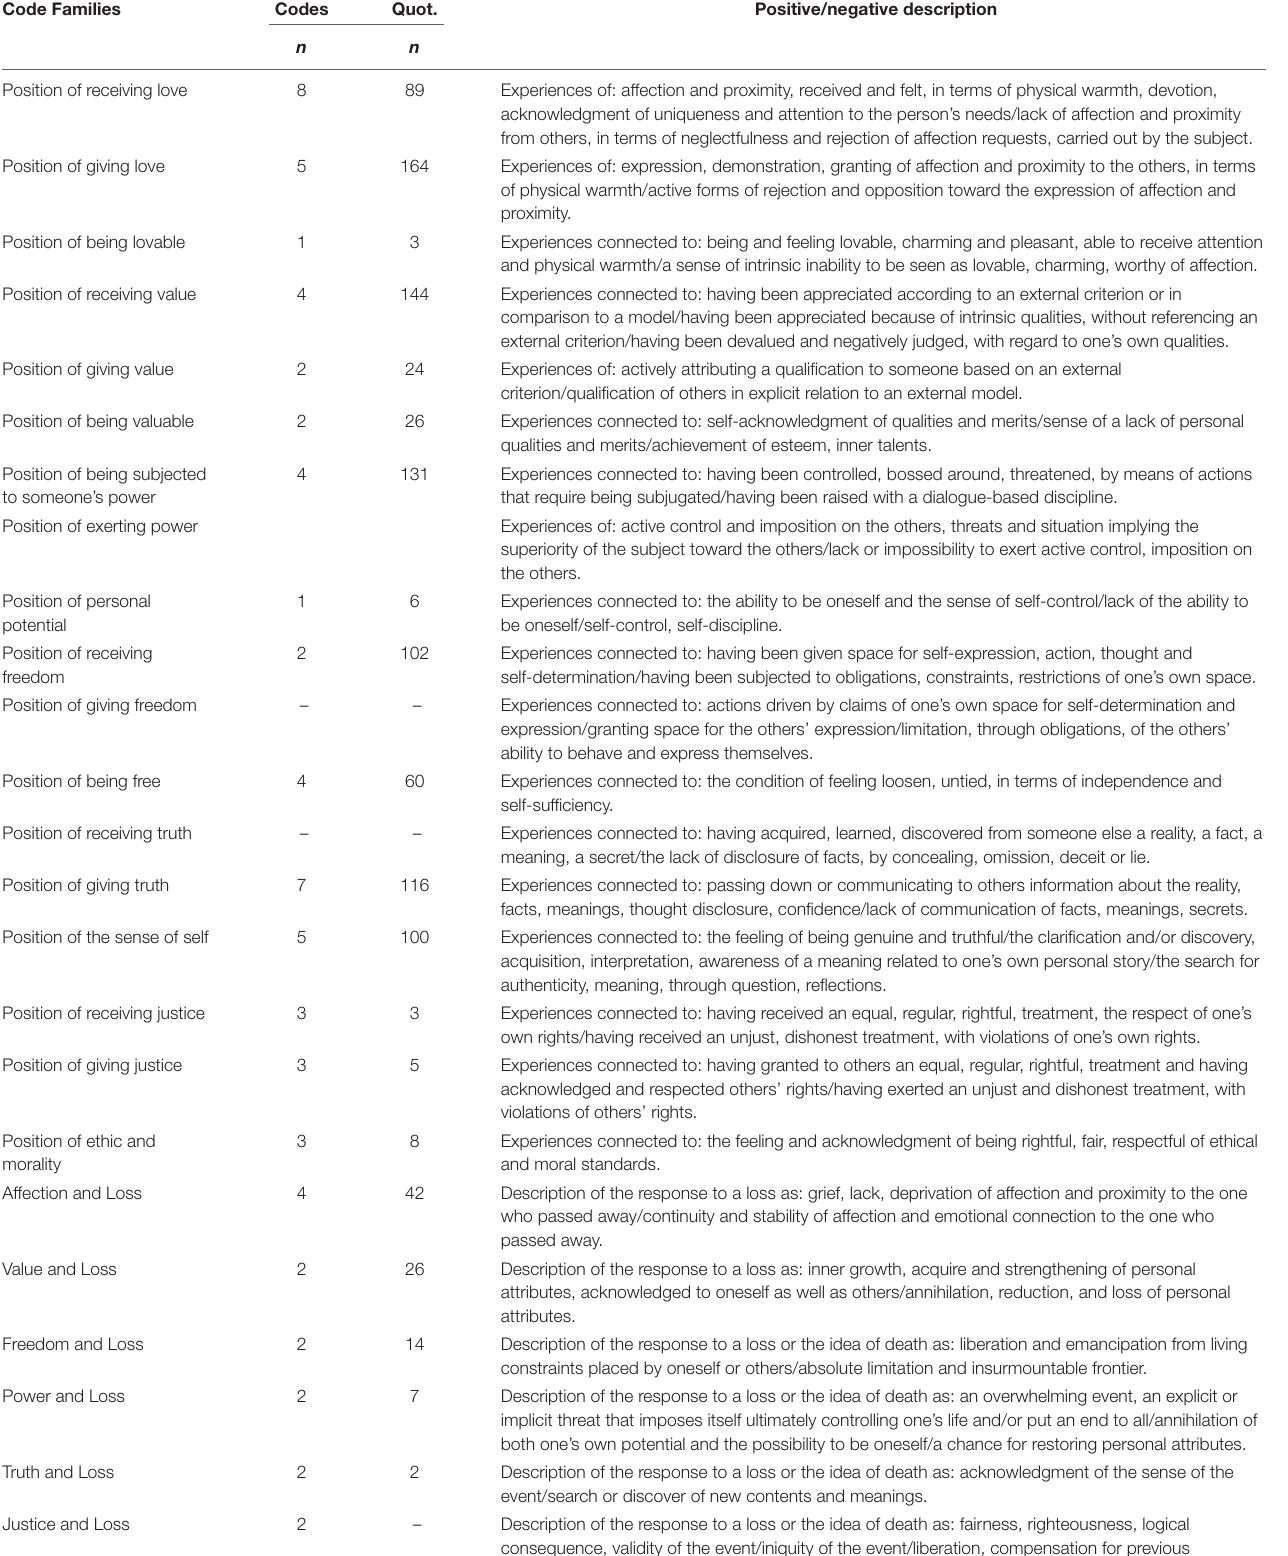
TABLE 5 | Code Families in the second Hermeneutic Unit (HU2). Code Families Codes